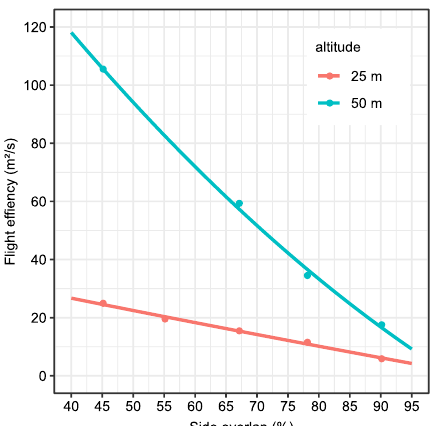
Figure 10. Influence of side overlap and altitude on area covered per time unit derived from Figure 6c. Equation and regression coefficients are in Supplementary Table